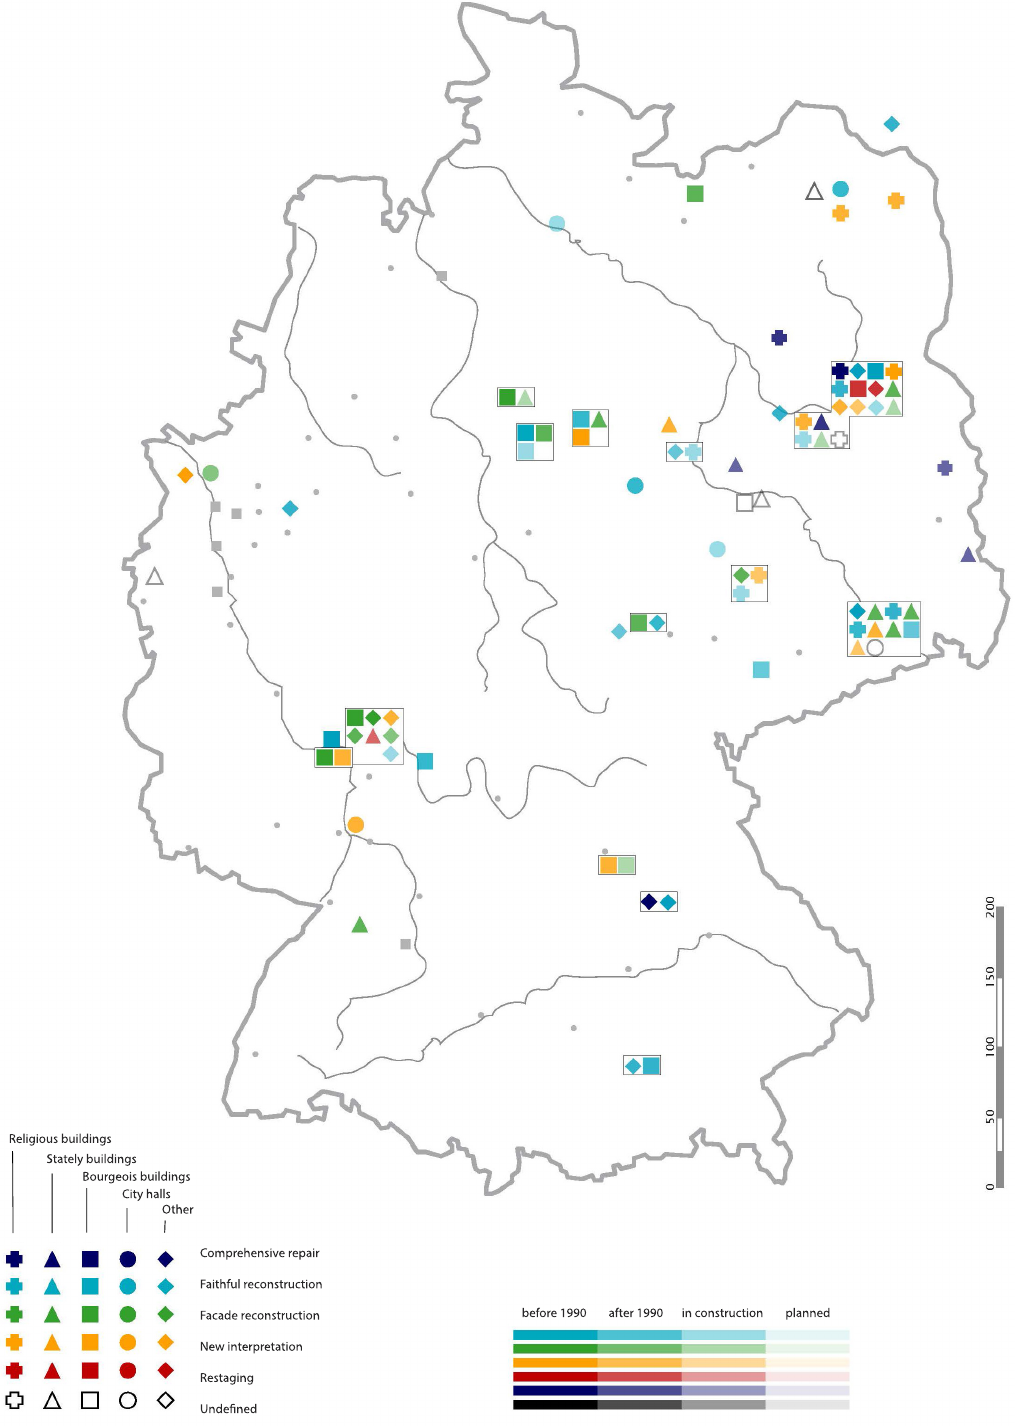
Figure 1. Spatial and temporal distribution of reconstruction projects in Germany, 1975–2009. Source: Map by G. Bertram, published in Altrock et al. (2010, p. 27), and translated by U.